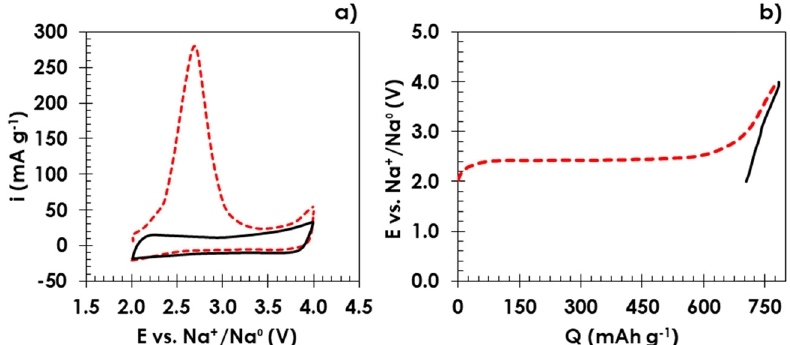
Figure 1: Electrochemical performance of the NaBH 4 /AC composite electrode versus metallic sodium counter/reference electrode in the electrolyte: ( a ) cyclic voltamperometry at 0.06 mV s − 1 ( 1st cycle: red dashed line; 2nd cycle: black solid line ) ; ( b ) galvanostatic charge/ discharge at C/20 up to 4.0 V vs N + /Na 0 ( charge: red dashed line; discharge: black solid line )